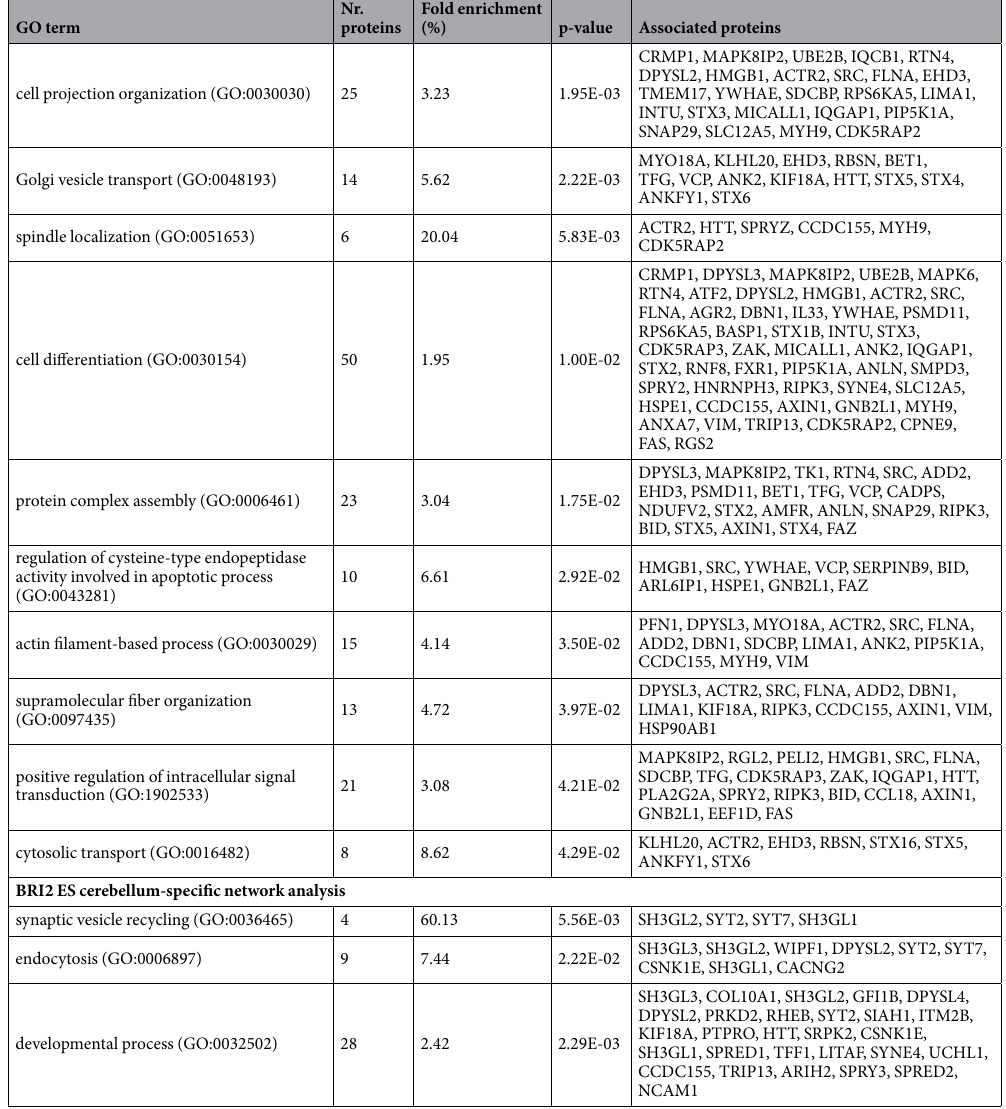
Table 3. Biological process enrichment analysis of the BRI2 ES regional specific networks (cerebral cortex, hippocampus, and cerebellum) using Panther online resource. Enriched categories are identified as those with p-value < 0.05, and GO terms presented correspond to the two most specific for each category retrieved in the analysis. Nr.